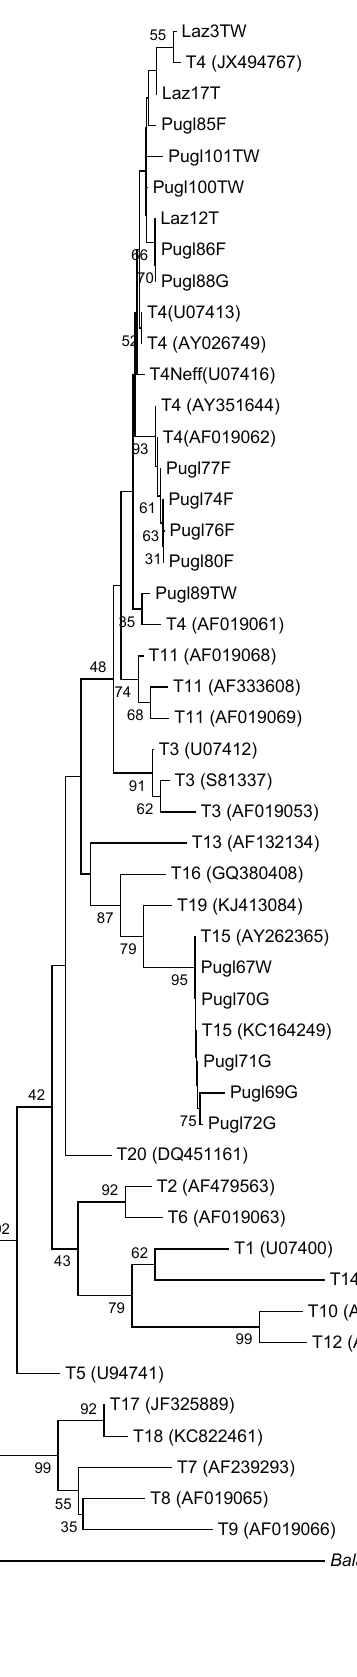
Figure 2. Phylogenetic relationships of 18 Acanthamoeba isolates inferred by NJ analysis based 18S-rRNA gene sequences. Only bootstrap values >35 are reported. GenBank accession numbers of reference strains are indicated in